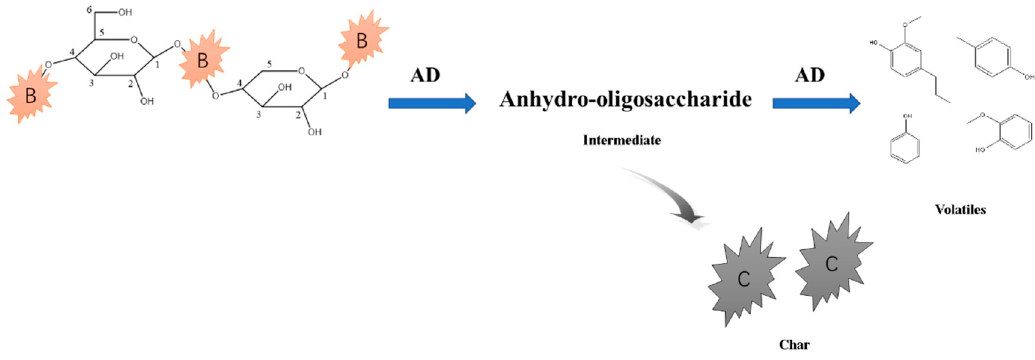
Figure 12. Scheme 4 for the formation of phenols from cellulose and hemicellulose catalyzed by AD.